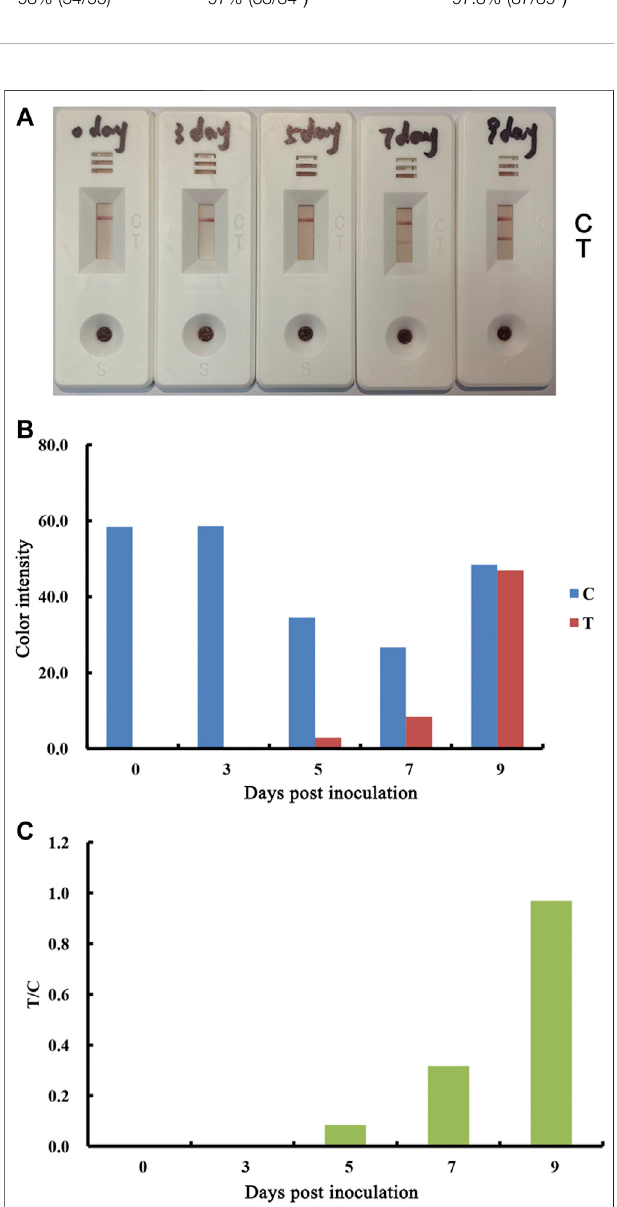
FIGURE 6 | Performance of lateral fl ow strip for the detection of ASFV antibodies in early stage of exposure. Real detection fi gures of ASFV antibodiesbylateral fl owassay.Bloodsampleswerecollectedattheindicated timepoints from pigs inoculated with 10 3 doses of ASFV (A) . The color intensity values of the test line (T value) and control line (C value) of the lateral fl ow assay (B) . The T/C value of the lateral fl ow assay (C)